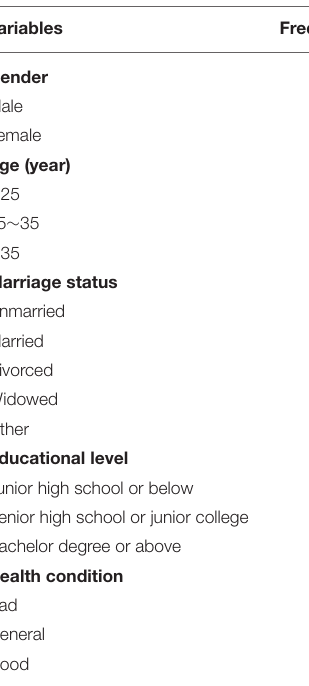
TABLE 2 | General demographic data of respondents ( N = 102).